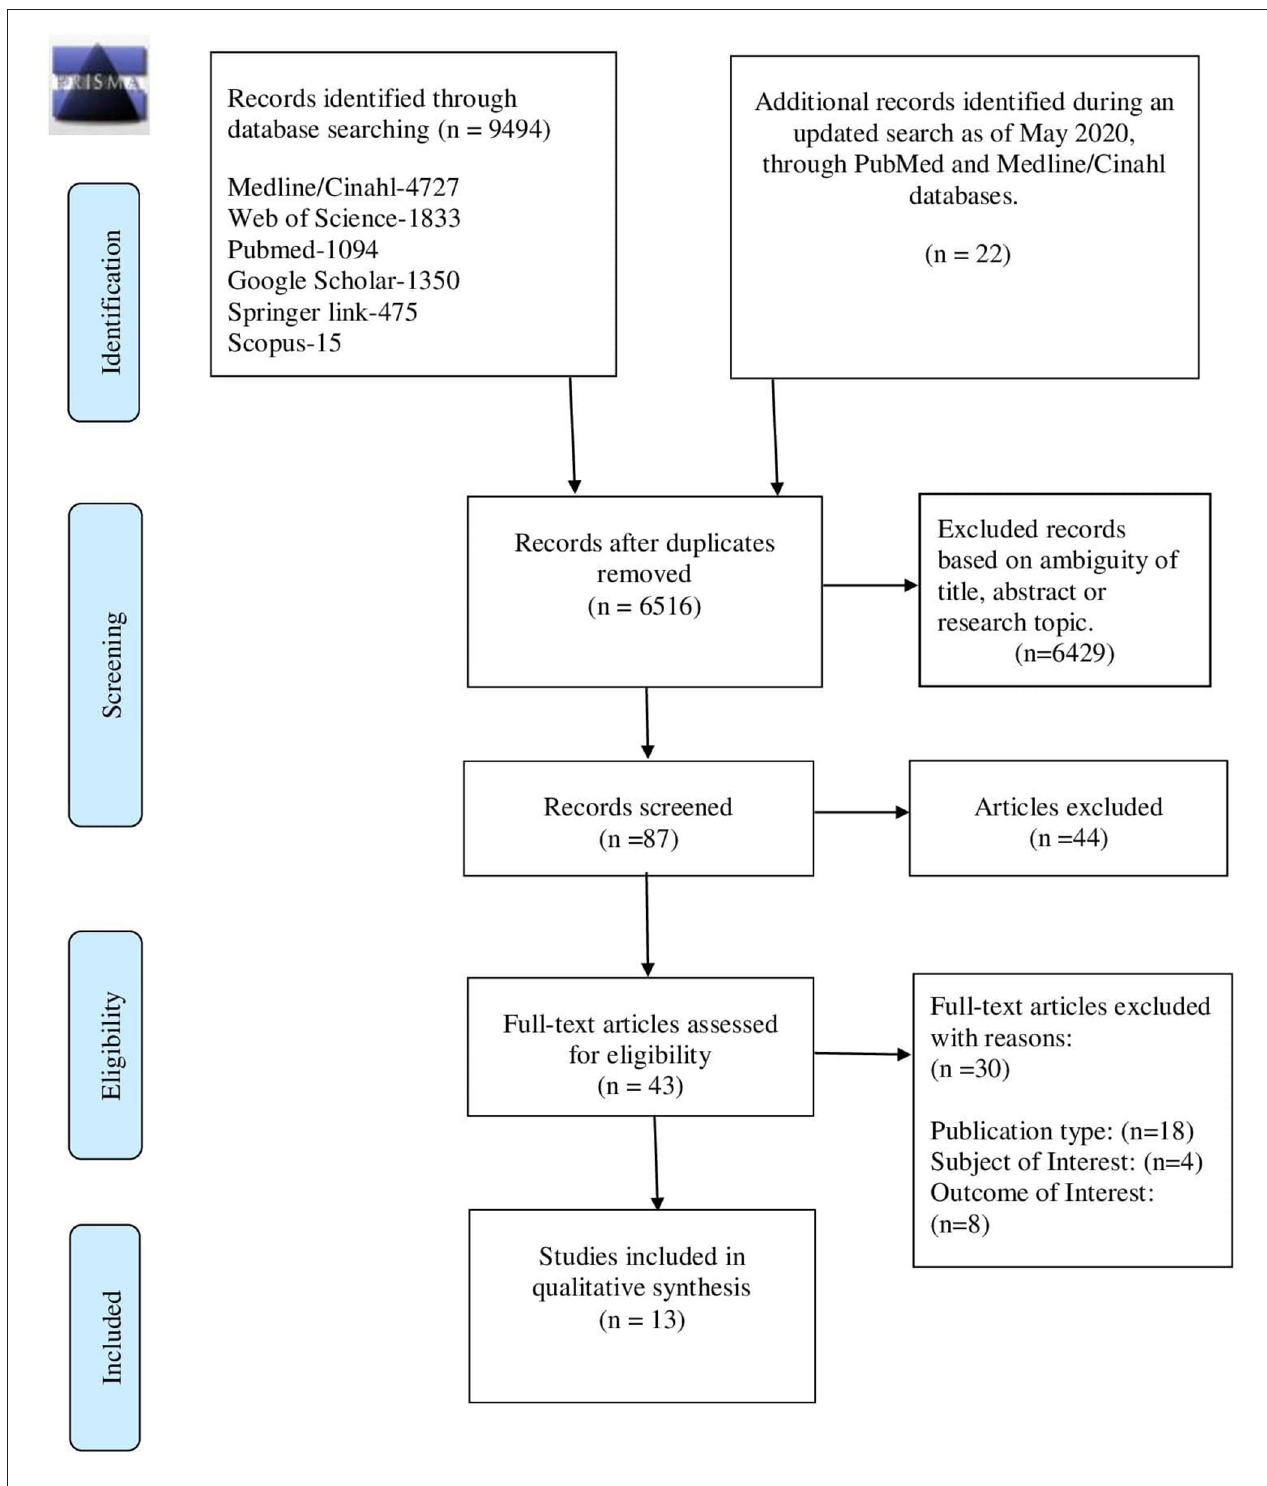
FIGURE 1 | Study selection flow chart—PRISMA 2009 flow diagram (7).